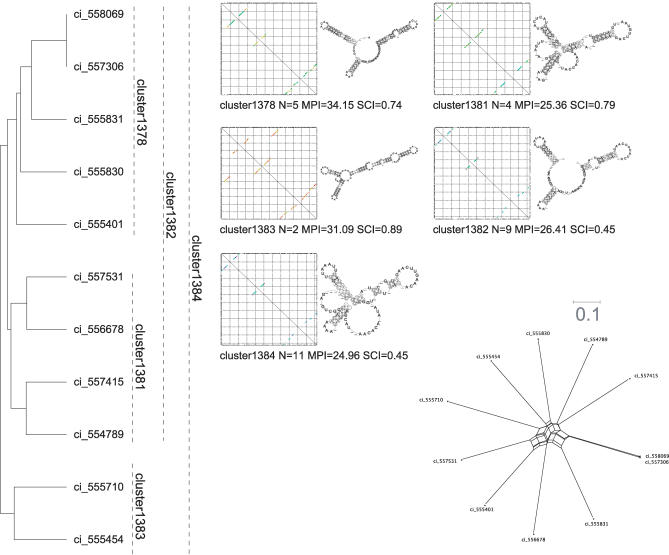
Cluster 1384 Groups Sequences with a Well-Conserved Secondary Structure Consisting of Three Stem LoopsWhereas the sequence identity is low, we observe a high structural conservation. N, number of sequences in cluster.